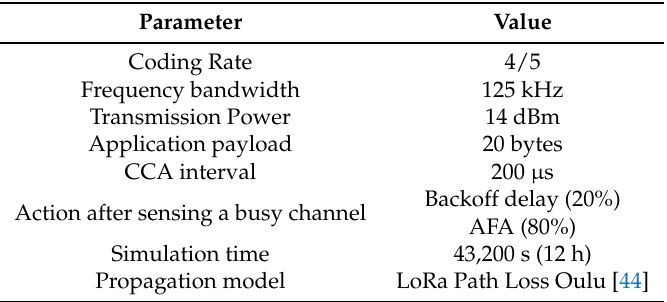
Table 3. Simulation parameters.